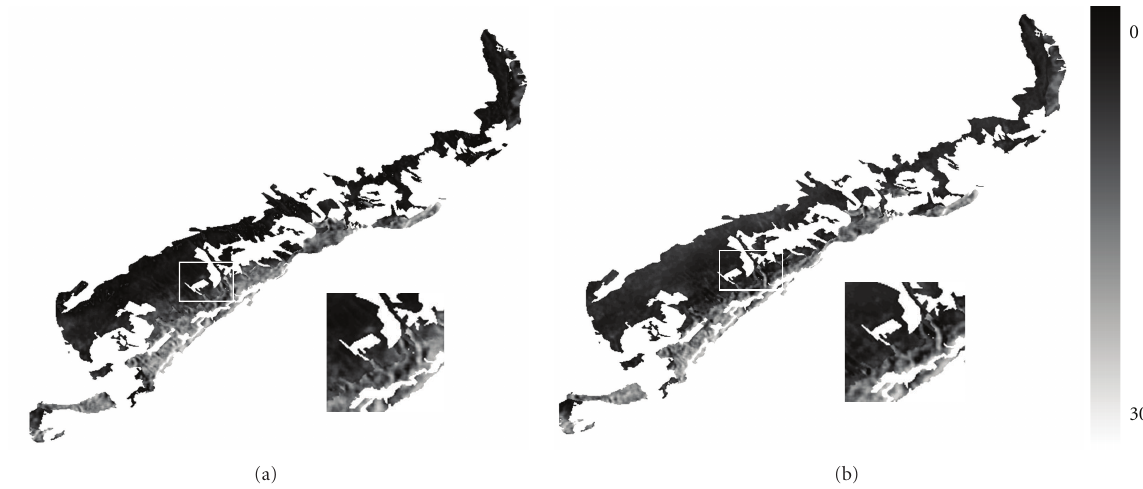
Figure 8: Maps of the dielectric constant of the east side of the Mazia valley: (a) 3rd June 2010 and (b) 21st July 2010. The small squares represent a zoom over particular areas extracted from the maps of June and July (indicated with the white